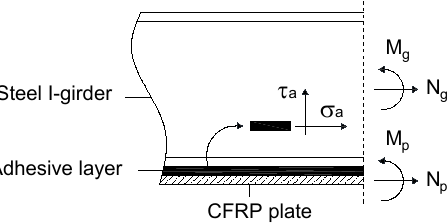
Figure 2. Equilibrium between girder, adhesive, and CFRP plate.